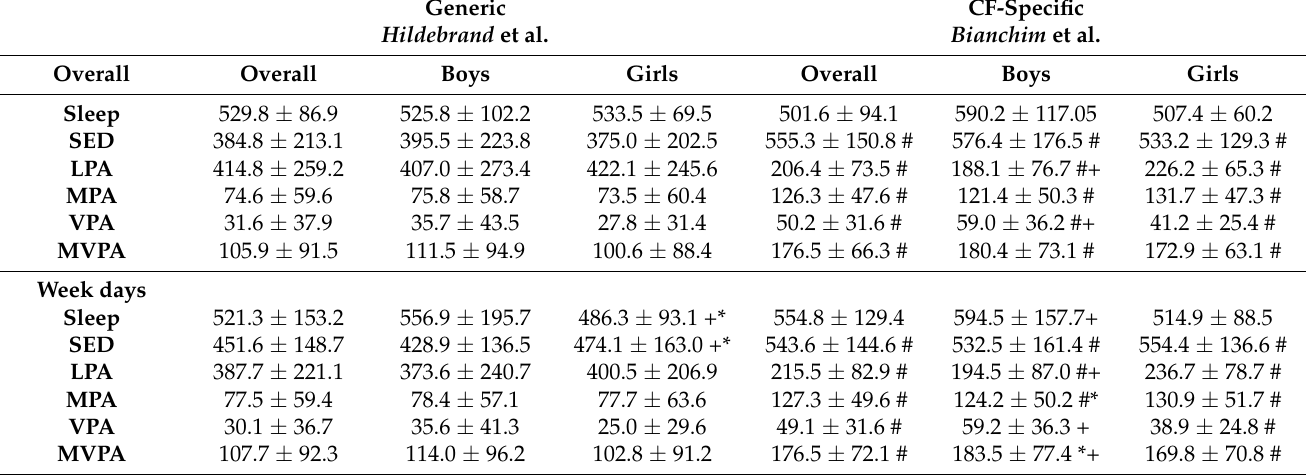
Table 2. Physical activity levels across weekdays, weekend days and overall (weekdays and weekend) by sex and